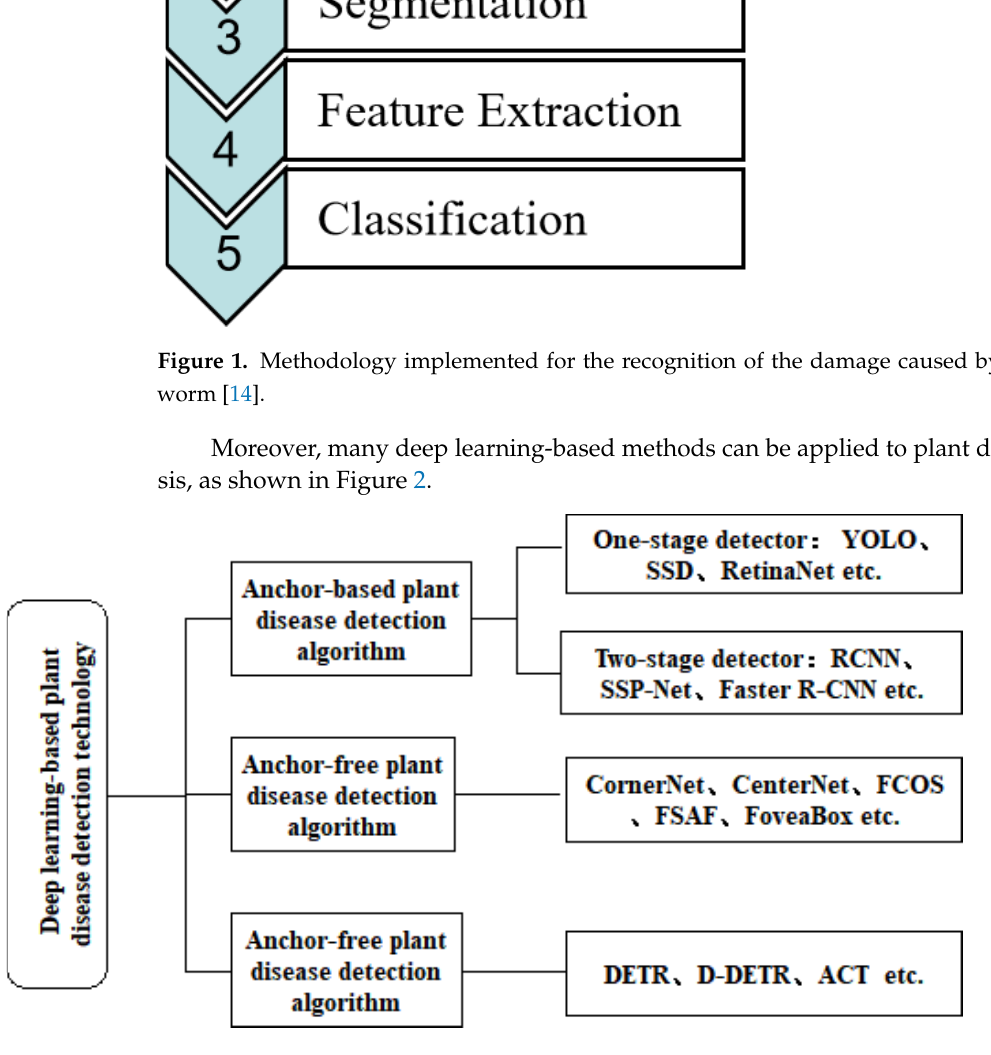
Figure 2. Deep learning-based plant disease detection technology.